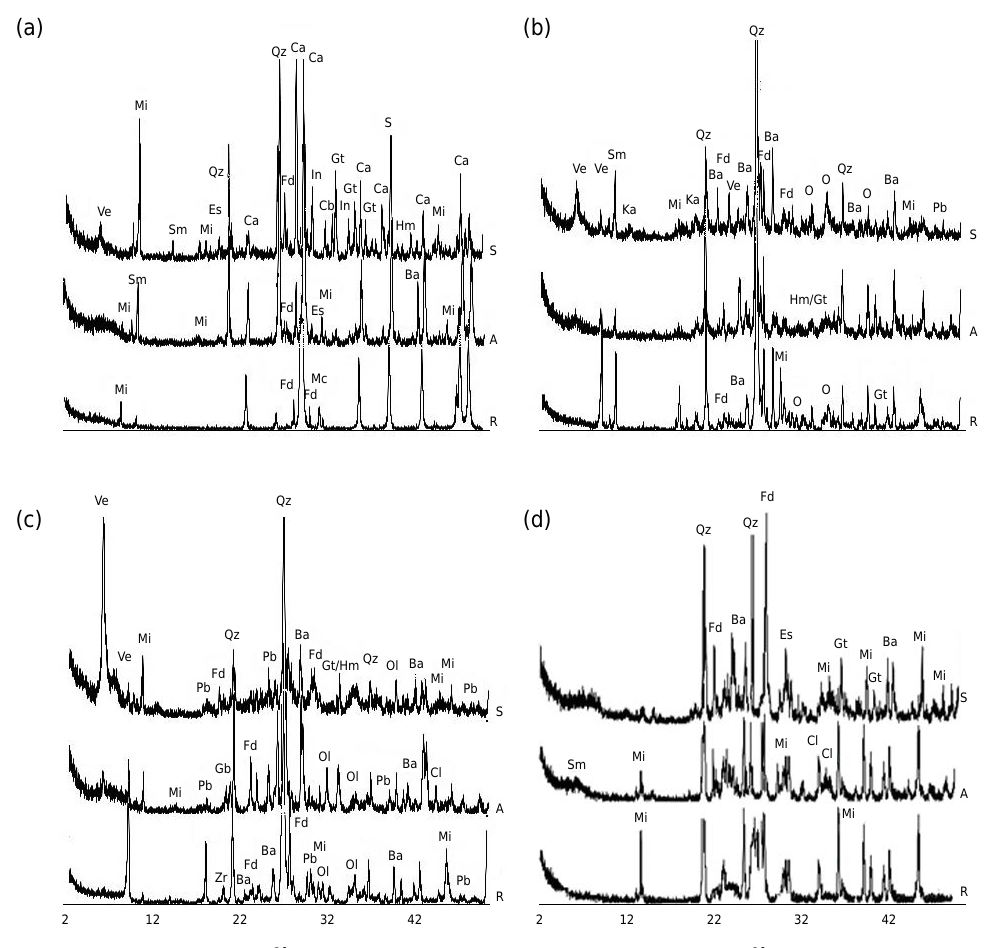
Figure 3. X-ray diffractogram patterns (CuKα radiation) of silt (S), sand (A), and rock (R) from area 1 (sample 4) (a), area 2 [samples 15 (b) and 23 (c)], and area 3 (sample 25) (d). Mi = mica; Fd = feldspars; Ca = calcite; Ba = barite; Ve = vermiculite; Sm= smectite; Ka = kaolinite; Qz = quartz; Zr = zircon; Ol = olivine; Hm = hematite; Gt = goethite; Gb = gibbsite; Pb = plumbogummite; Cl =